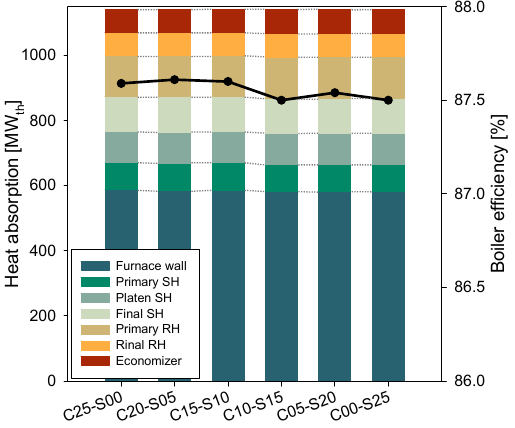
Figure 12. Solid carbon concentration and path-lines of CCOFA (foe C25-S00) and SOFA (for C10-S15 and C00-S25).